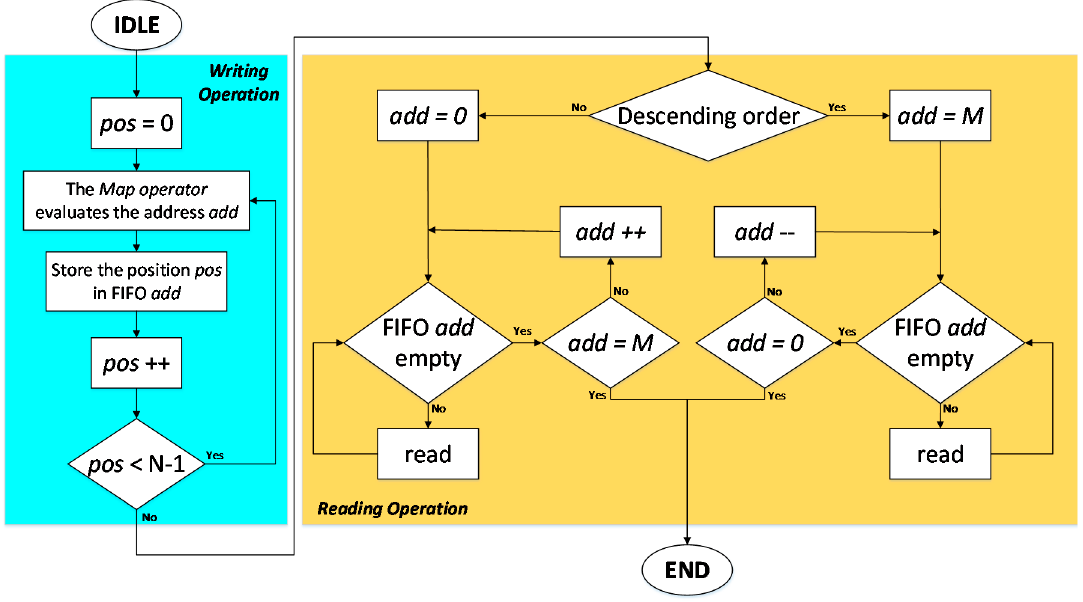
Figure 12. Flow chart that describes the state machine in Figure 10.